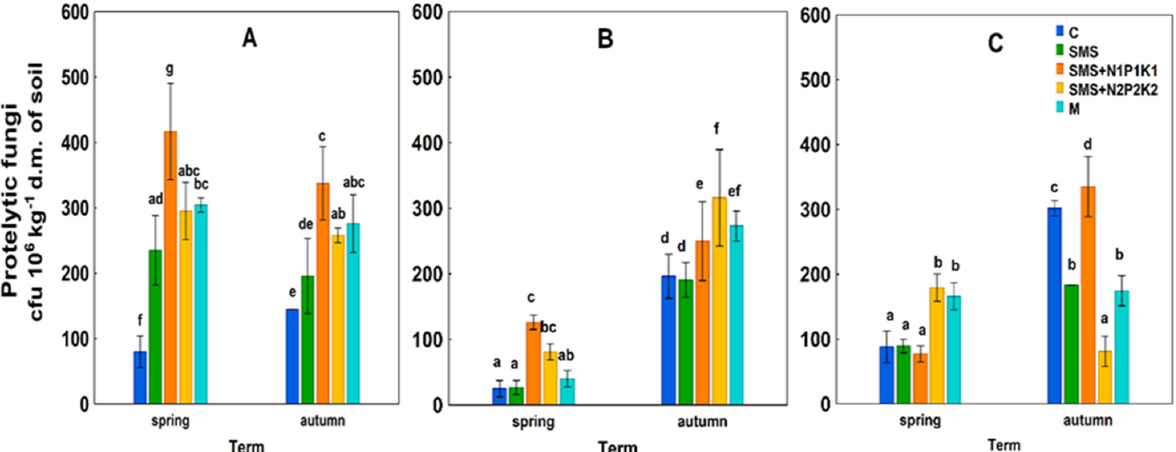
Figure 4. Number of proteolytic fungi in the control soil and soil under different treatment strategies. Legend: M—soil + manure; ( A )—1st year; ( B )—2nd year; ( C )—3rd year. The vertical lines indicate the standard deviation. Different letters above the columns indicate significant differences, each year was analyzed independently of each other.